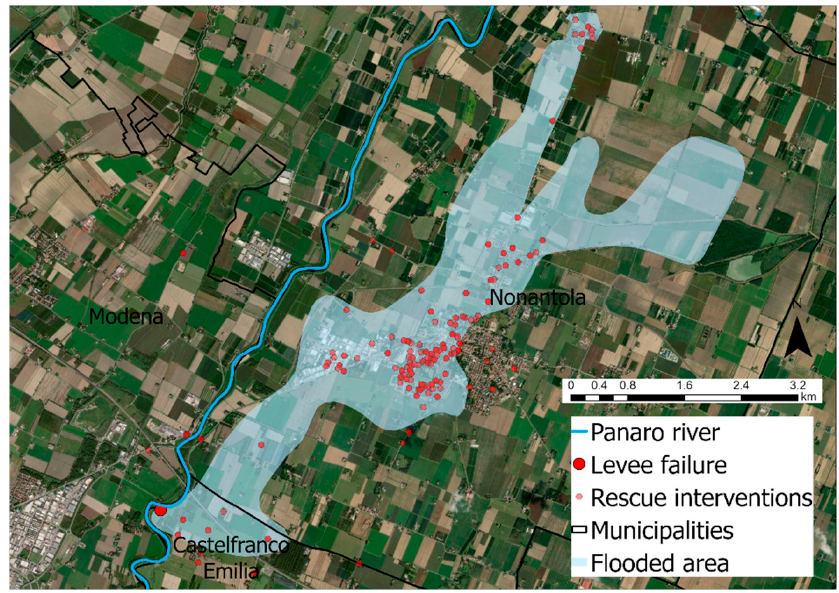
Figure 6. Flooded area obtained after data processing: the perimeter has been obtained from the helicopter and the technical commission surveys, and points represent the interventions of the Fire Corps.